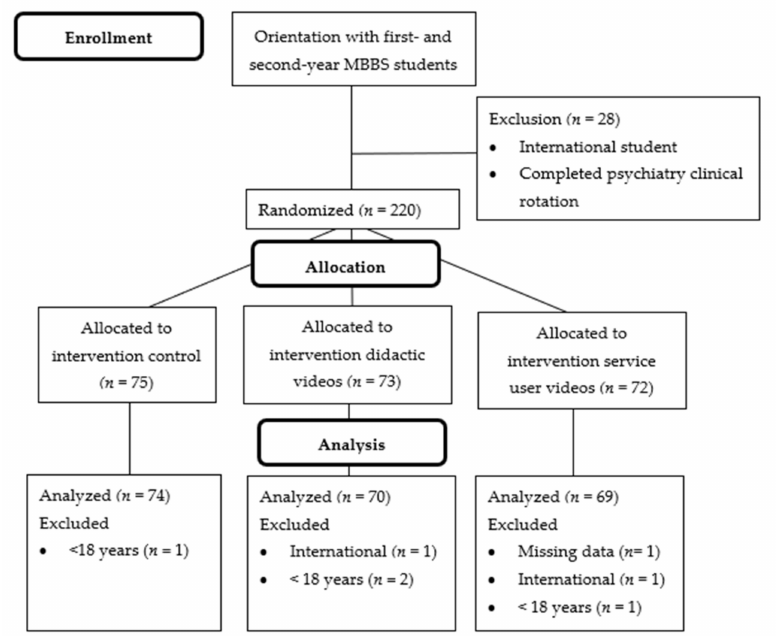
Figure 3. CONSORT participant flow diagram for research procedures in Study 2 (depression and psychosis). Abbreviations: MBBS—Bachelors of Medicine, Bachelors of